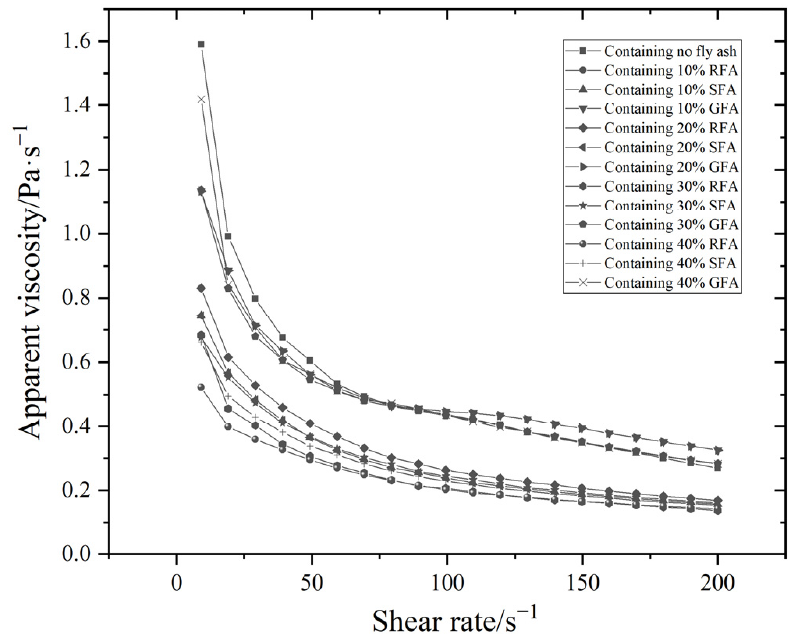
Figure 6. Apparent viscosity of cement paste.